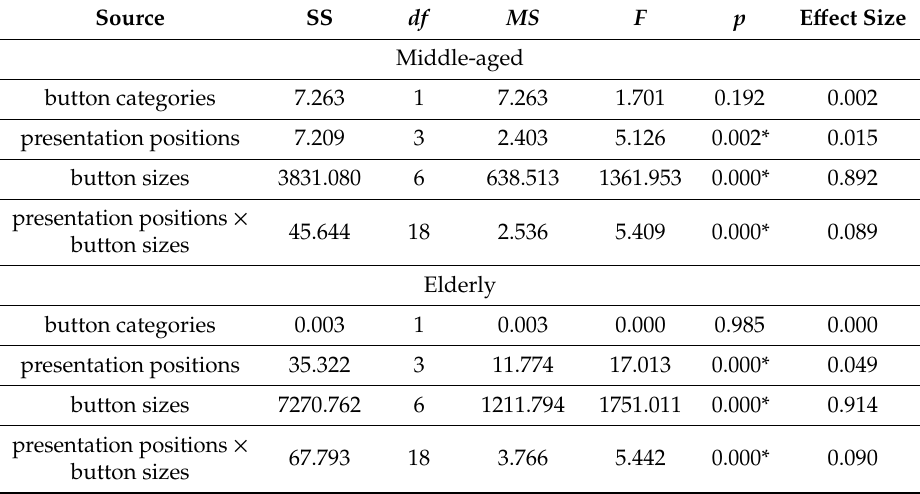
Table 2. ANOVA table for button categories, presentation positions, button